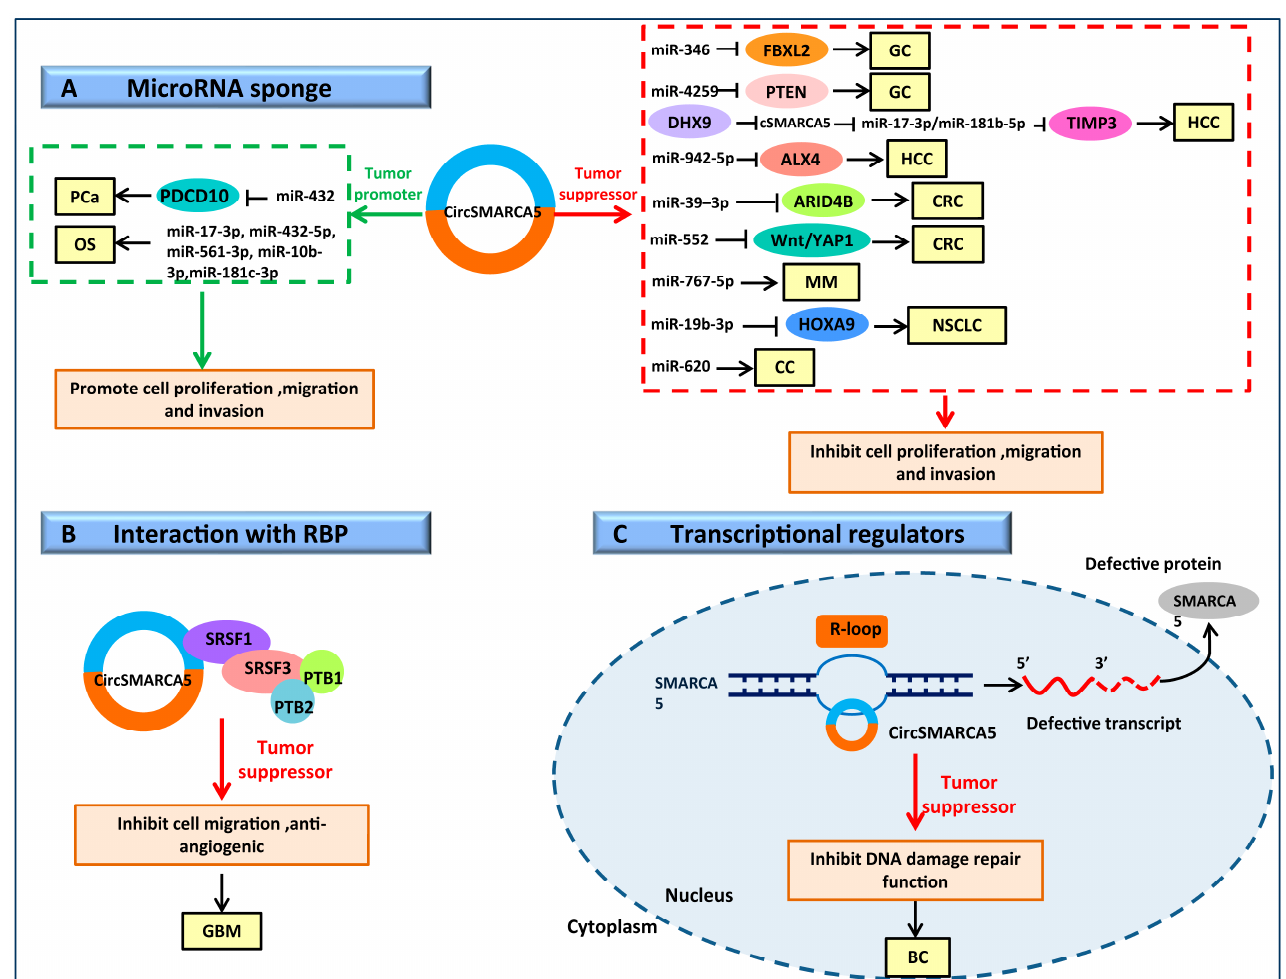
Figure 2. Mechanisms in various types of tumors of circSMARCA5. ( A ) CircSMARCA5 acts as a miRNA sponge. CircSMARCA5 functions as a miRNA sponge to adsorb multiple miRNAs, thus regulating the expression of downstream genes and cancer progression. ( B ) CircSMARCA5 interacts with RNA binding protein SRSF1 thus regulating the cell migration and angiogenic potential. ( C ) CircSMARCA5 can bind to SMARCA5, forming an R-loop, resulting in the production of a truncated nonfunctional protein, thus inhibiting DNA damage repair function.